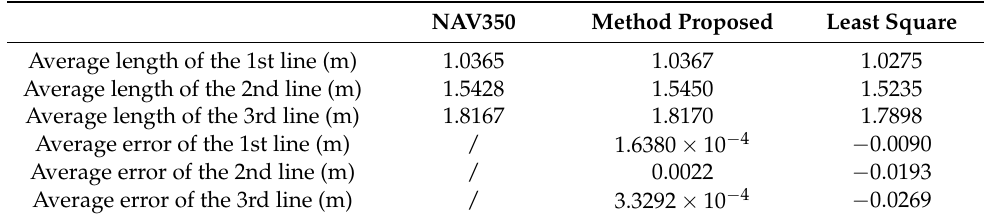
Table 2. Different algorithms’ performance of fitting reflector coordinates.